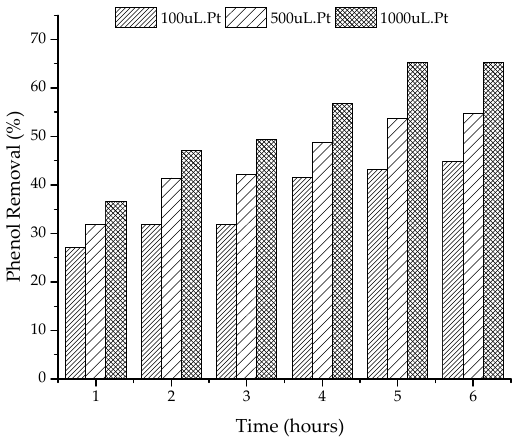
Figure 6. Kinetics of heterogeneous photocatalysis reaction in seawater with 0.0125 g of catalyst, 1 to 6 h of UV light, an amount of platinum (100, 500, or 1000 μ L), and pH = 3.5.